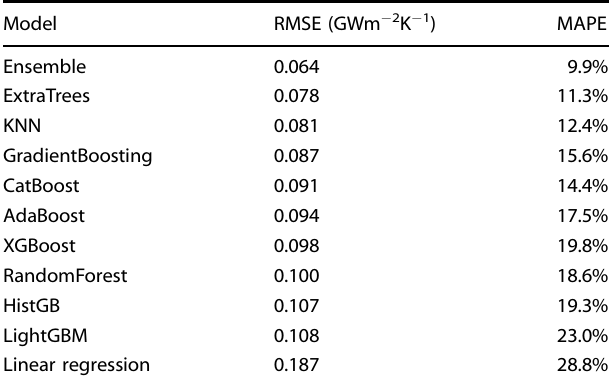
Table 1. Six-fold cross-validation results for thermal boundary conductance prediction of all training structures, ordered by root mean squared error (RMSE).